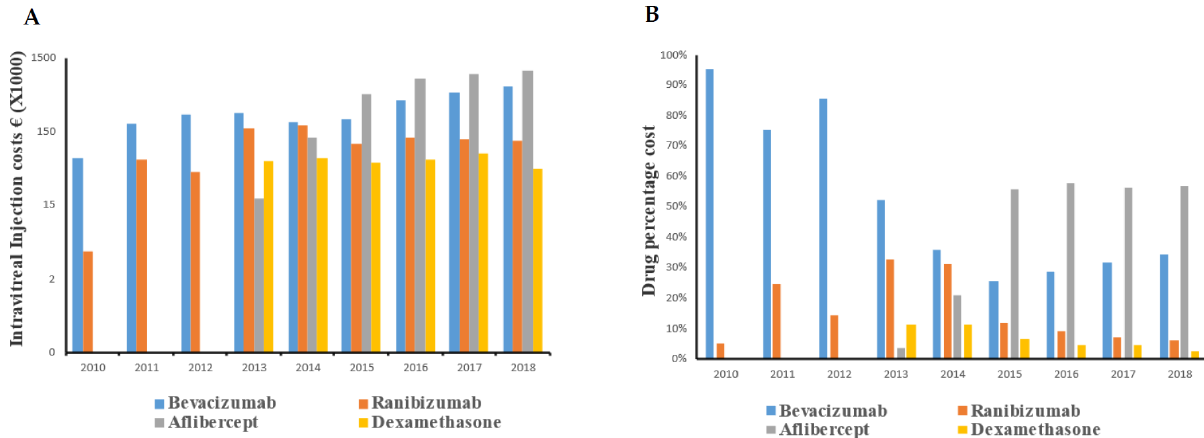
Figure 4. Total costs per year of each intravitreal drug ( A ) and percentage of the total cost per year for each of those drugs ( B ).